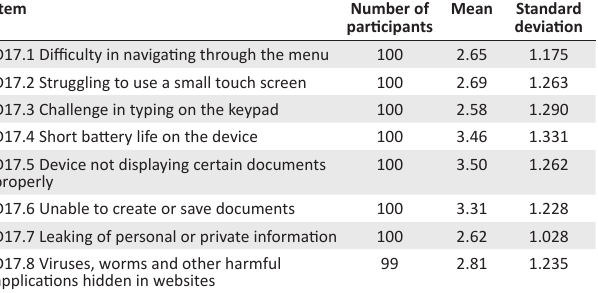
TABLE 5: Descriptive statistics for challenges in the usage of smart devices.